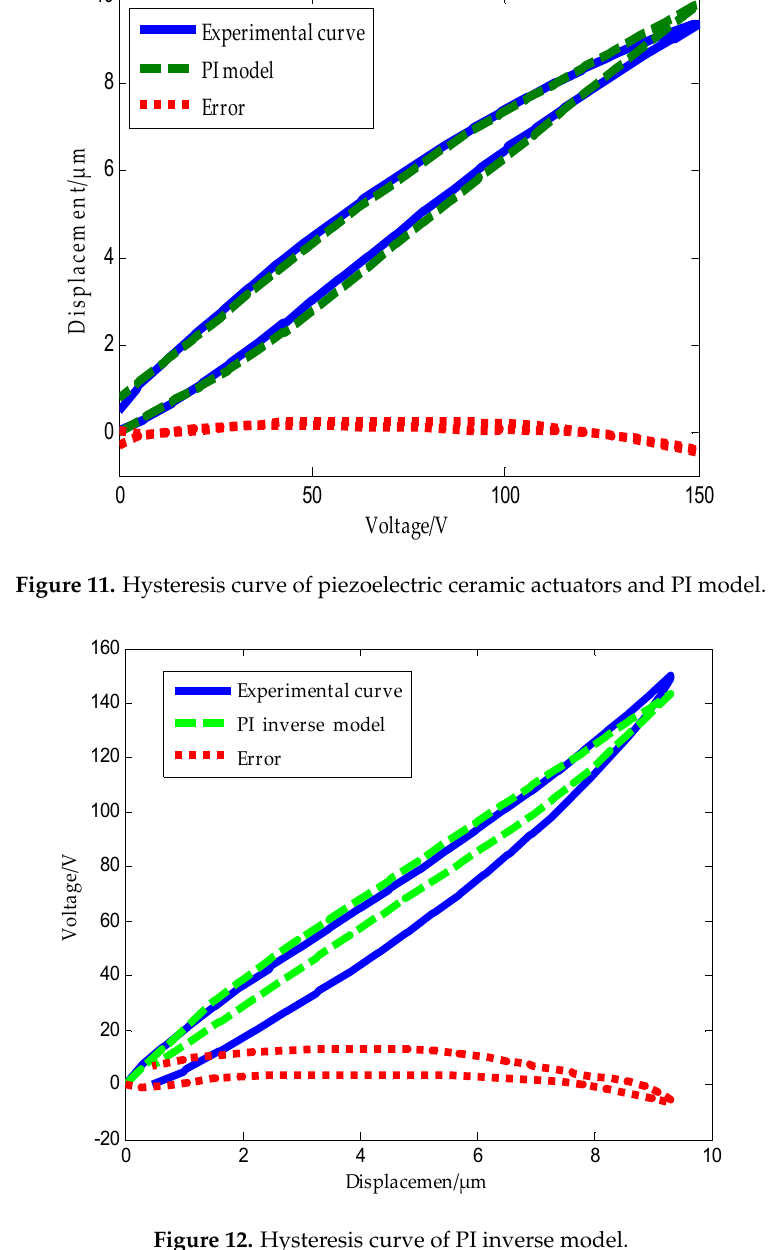
Figure 12. Hysteresis curve of PI inverse model.